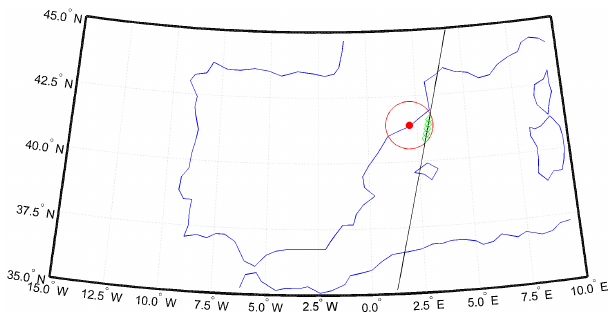
Figure 1. CALIOP overpass over Barcelona station on 20 Septem- ber 2011 at 02:00UTC at 77.9km distance from the station. The red circle shows 100km distance from the EARLINET station (the red dot in the centre). The black line represents the CALIOP ground track, while the green empty diamonds represent five CALIOP pro- files that were averaged and compared to EARLINET measure-